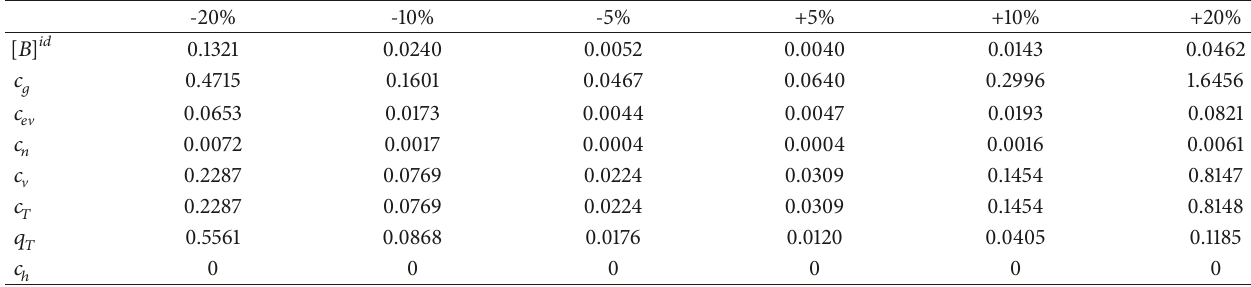
Table 5: Sensitivities ( 𝑆 ) of the model to the changes of parameters [𝐵] 𝑖𝑑 , 𝑐 𝑔 , 𝑐 𝑒 V , 𝑐 𝑛 , 𝑐 V , 𝑐 𝑇 , 𝑞 𝑇 , 𝑐 ℎ , 𝑞 𝐼 , and 𝑘 𝑉 in the no-therapy case. One unit is 10 6 mm 3